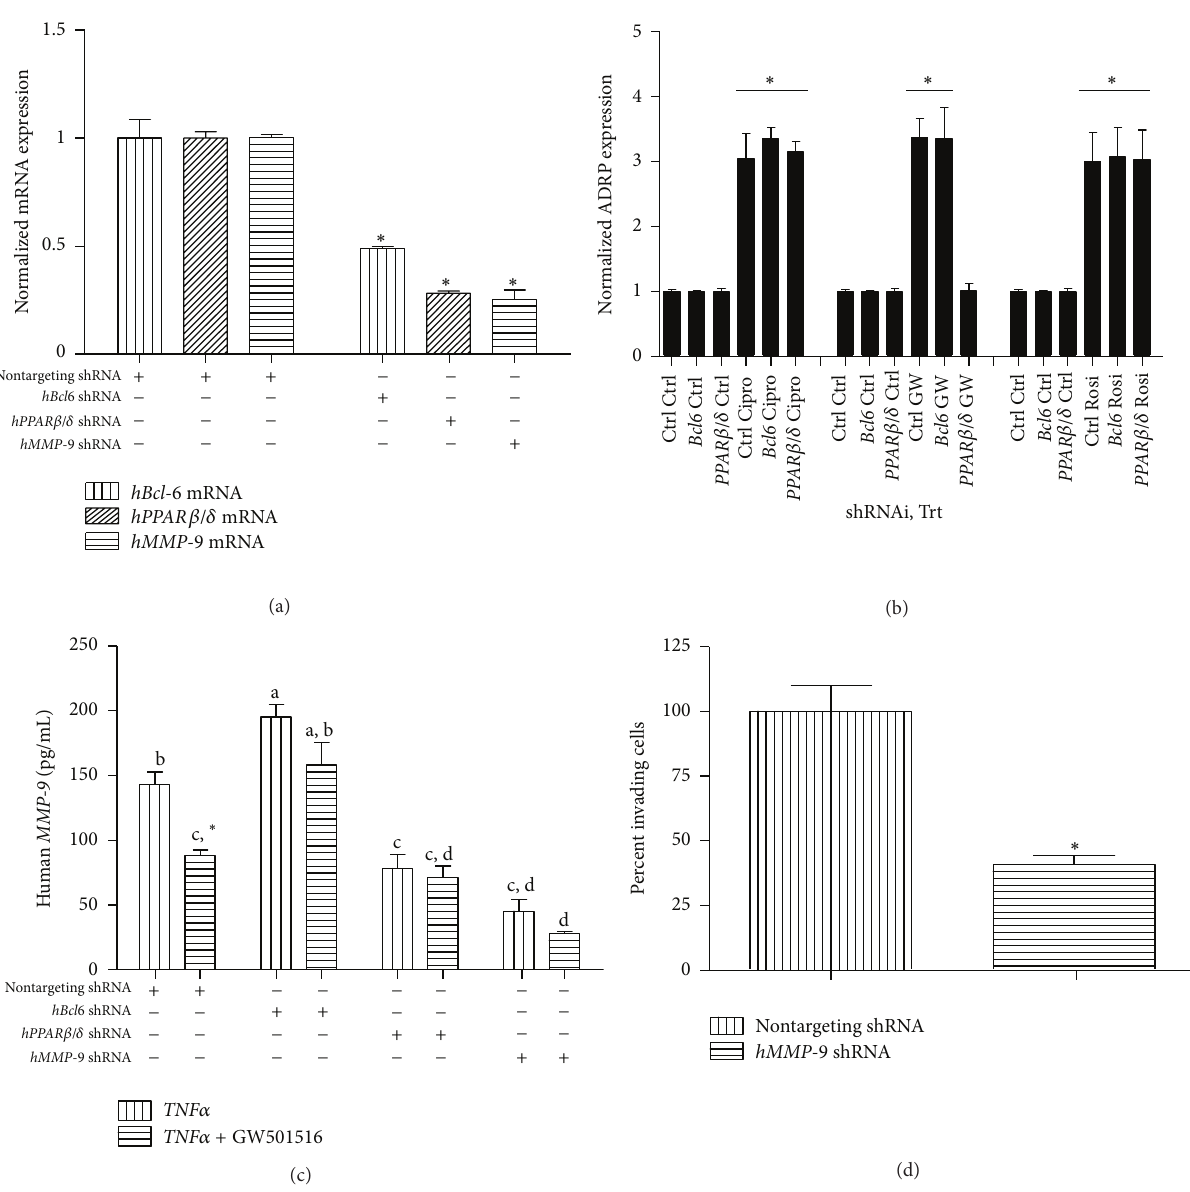
Figure 2: Effect of 𝑃𝑃𝐴𝑅𝛽/𝛿 activation on MMP-9 expression. (a) Miapaca-2 cells were transiently infected with nontargeting control, hBCL- 6, ℎ𝑃𝑃𝐴𝑅𝛽/𝛿 , or hMMP9 lentiviral shRNAs for 48 hours. Total mRNA was isolated and gene-specific knockdown was assessed using qRT- PCR. ∗ 𝑃 < 0.05 . (b) Miapaca-2 cells contain functional PPAR s. Miapaca-2 cells were transiently infected with the indicated shRNAs and treated with the indicated PPAR isoform-specific agonists. Induction of the PPAR -target gene ADRP was determined using qRT-PCR. ∗ 𝑃 < 0.05 . (c) Miapaca-2 cells were stimulated with human 𝑇𝑁𝐹𝛼 with or without GW501516 for 24 hours following transient infection with the indicated shRNAs. Human MMP-9 protein expression was quantified using MMP-9 -specific ELISA (Invitrogen). ∗ 𝑃 < 0.05 . (d) Miapaca- 2 cells with reduced MMP-9 expression are less invasive than control Miapaca-2 cells. Following infection with human MMP-9 -targeting shRNA, Miapaca-2 cells were seeded in 96-well invasion plates (Cell Biolabs, Inc.) and allowed to invade the basement membrane overnight. Relative cell invasion was quantified using the CytoSelect 96-well cell invasion assay with fluorometric readings at 480nm/520 nm. ∗ 𝑃 < 0.05